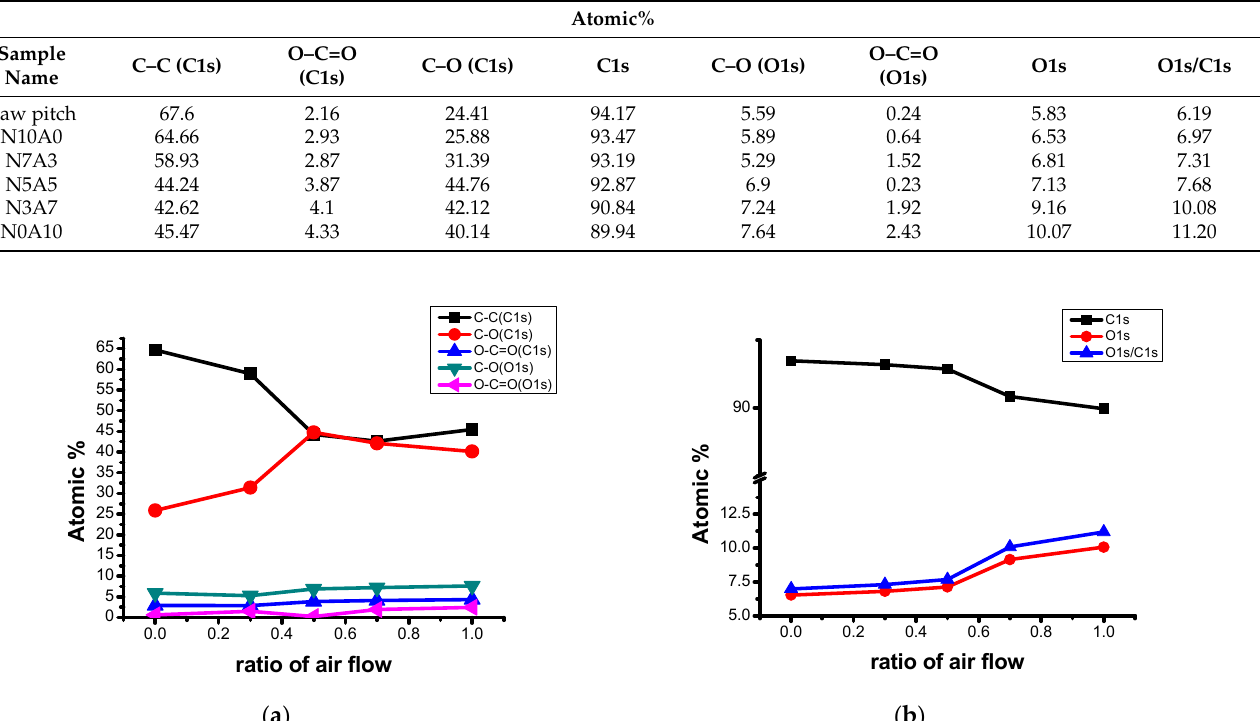
Figure 3. ( a ) Atomic% of the functional group relate to C and O, ( b ) Ratio of O1s/C1s.